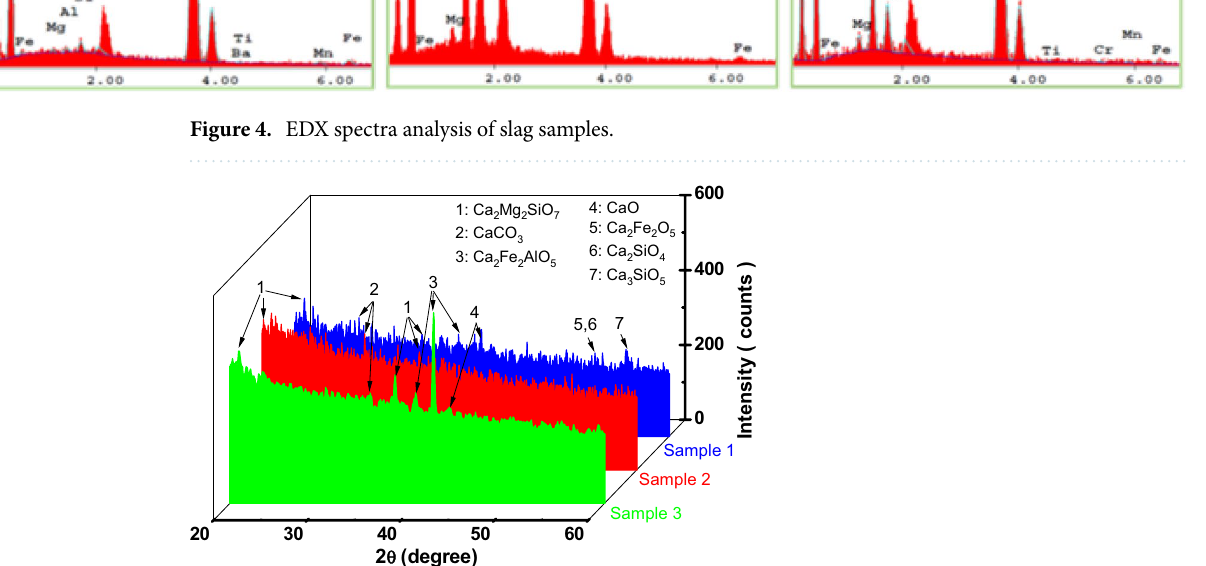
Figure 5. X-ray diffraction patterns of slag